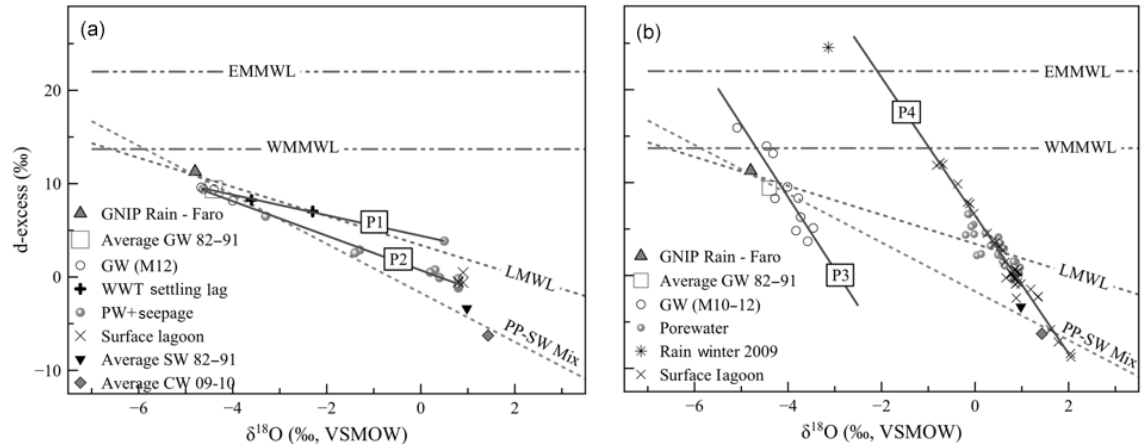
Figure 7. Hydrological pathways within the Ria Formosa, as defined by stable isotope data. (a) 2007 situation – SGD with net input of meteoric water present; (b) 2009–2011 – SGD essentially derived from tidal pumping. Detailed explanations are available in Sect.